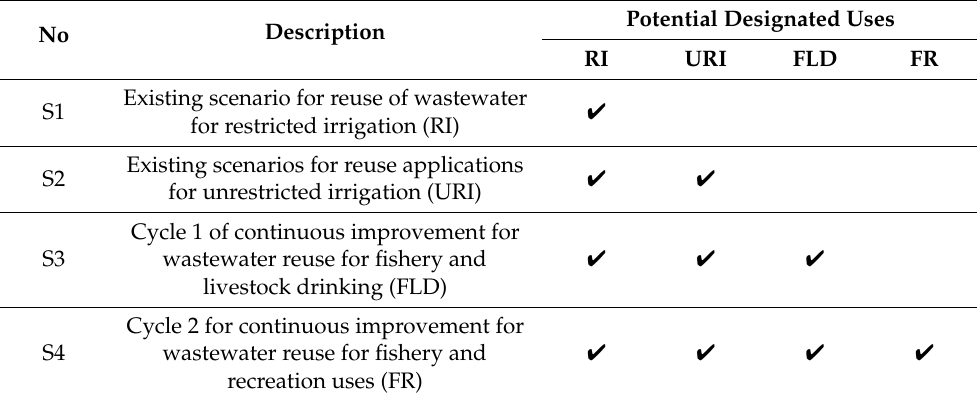
Table 1. Wastewater reuse scenarios for CPI.